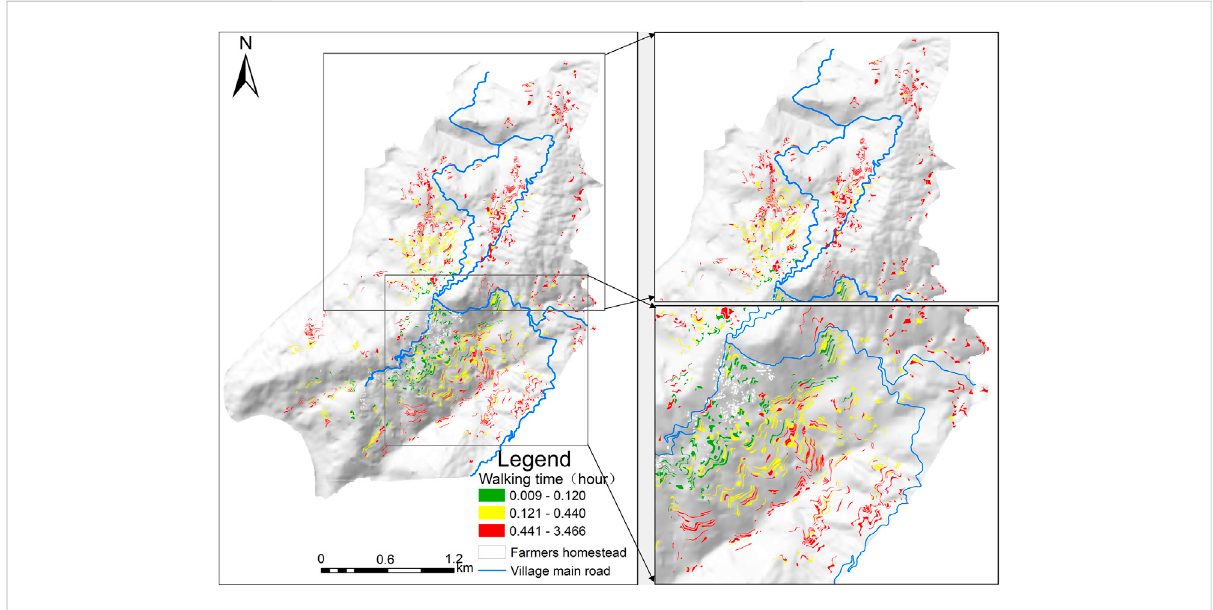
FIGURE 5 Homestead to plot walking